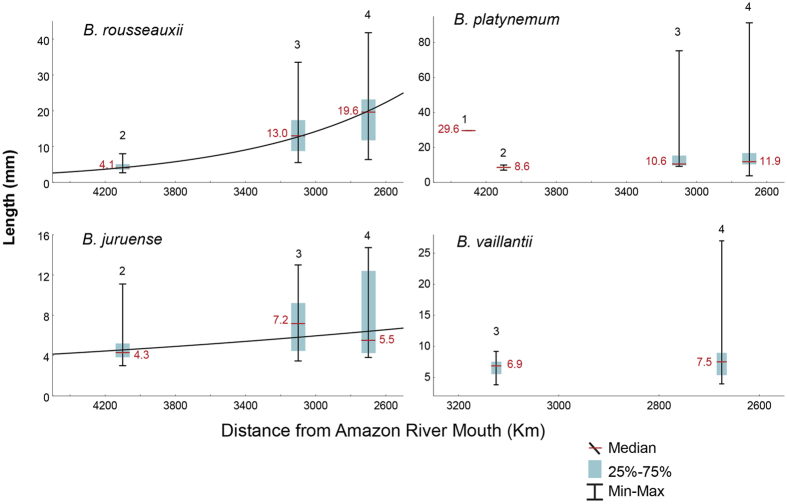
Downriver migration of goliath larvae/juveniles in the Madeira River system.Box-plots of the lengths of goliath catfish drifting larvae from near the Andes in the Madre de Dios River to the Madeira River in Brazil, approximately 1,600 km downriver. Collection sites are indicated by the numbers above the box-plots: 1- Madre de Dios River at Los Amigos River confluence, 2- Madre de Dios River at Puerto Maldonado, 3- Madeira River at Porto Velho, and 4- Madeira River at Humaitá. Data were fit to an exponential curve, where Lmm is the size in millimeters and km is the distance in kilometers: B. rousseauxii: Lmm = 269.1−0.00101×km, r2 = 0.67, F(1, 327) = 670, p < 0.001; B. juruense: Lmm = 18.5−0.00034×km, r2 = 0.22, F(1, 76) = 23.1, p < 0.001; B. platynemum: r2 = 0.17 F(1, 108) = 1.93 p > 0.05; B. vaillantii: r2 = 0.08, F(1, 34) = 2.9, p > 0.05.